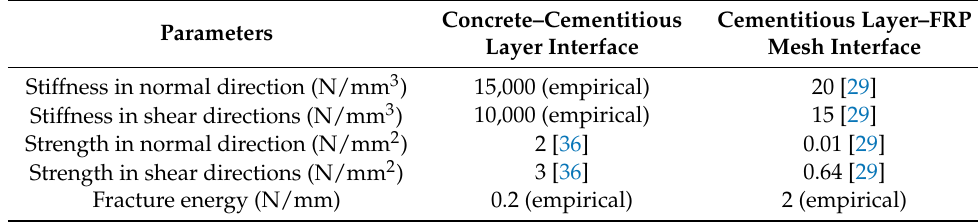
Table 3. Mechanical properties at the joint